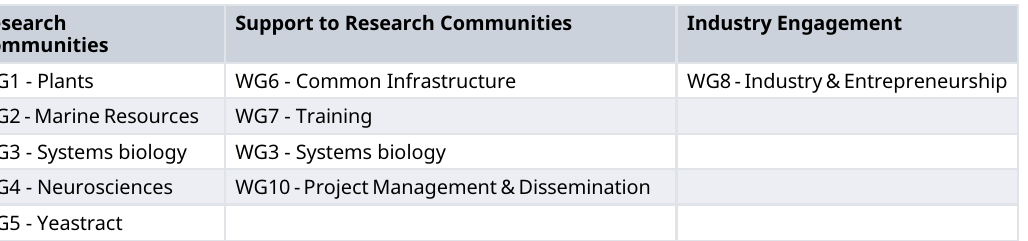
Table 1. Working groups (WG) of the “ Building BioData.pt ” project, which was instrumental to the creation and early operation of the BioData.pt